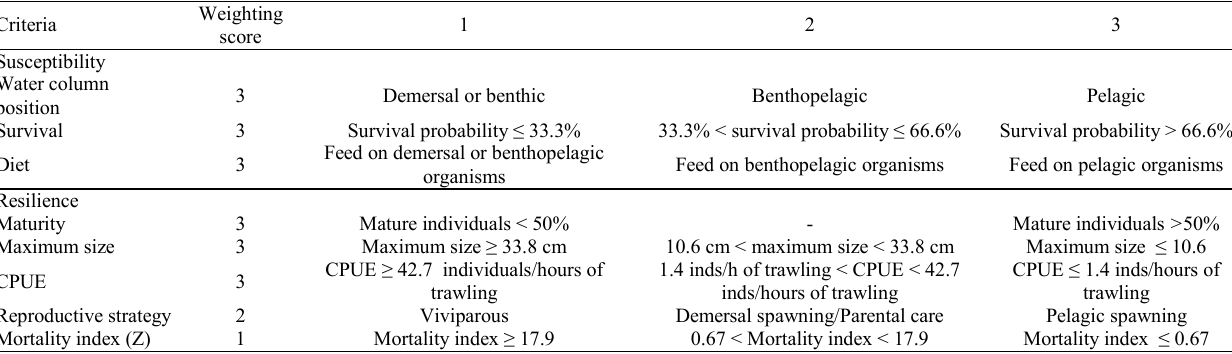
Table 1. Criteria used to assess susceptibility of bycatch species to capture and mortality due the trawling. For each criterion, the weighting score and definition was established on the tree